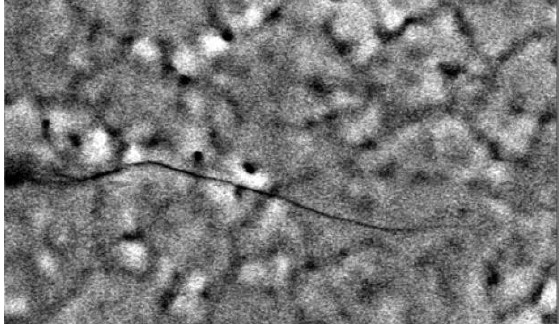
Figure 5. Fatigue-induced crack propagation in a polysilicon film, after [25] (© [2003] IEEE).